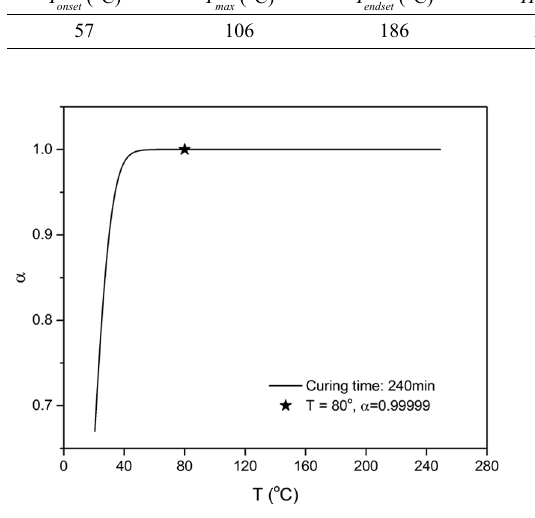
Figure 5. Epoxy system Araldite ® LY5052/Aradur5052 TM cure degree (α) forecast as a function of temperature (T) for a pre-established time of